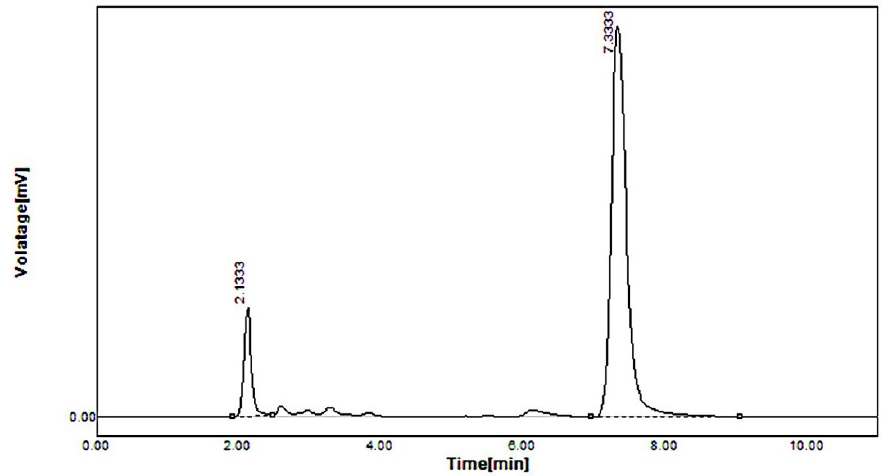
Figure 5. HPLC of simvastatin and its metabolite in feces of standard simvastatin − treated mice.